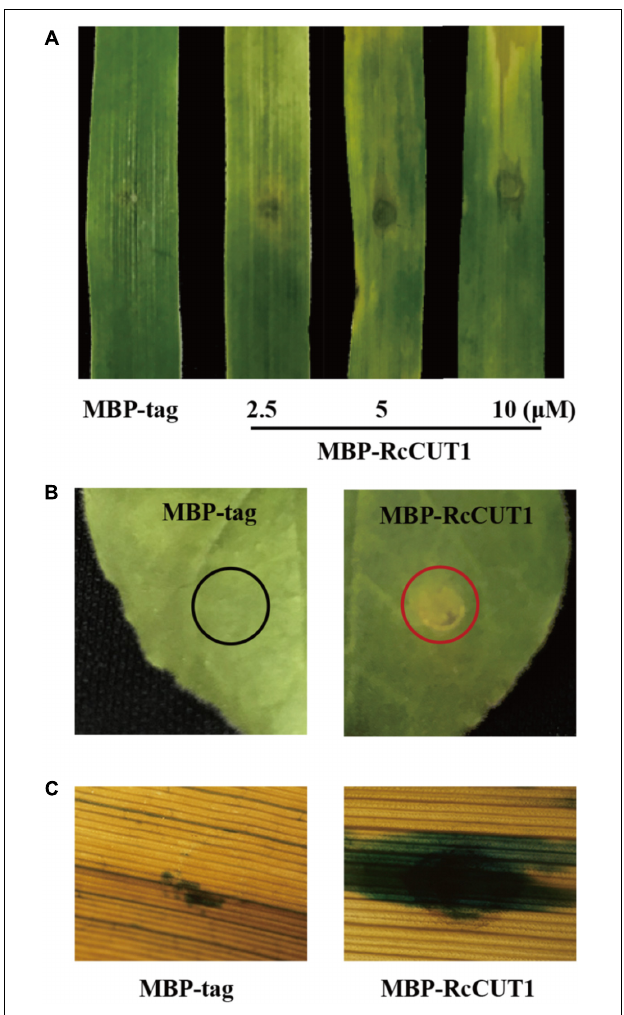
FIGURE 4 | The cell death induced by RcCUT1 in wheat and N. benthamiana leaves. (A) Wheat leaves 3 days post-inoculation with the MBP-RcCUT1 (2.5, 5, and 10 µ M) and the MBP-tag solution (5 µ M) as control. (B) N. benthamiana leaves with MBP-RcCUT1 treatment (5 µ M). The red and black circles indicate cell death and no cell death, respectively. (C) Wheat leaves with MBP-RcCUT1 treatment (5 µ M) stained by trypan blue. Dead wheat leaf cells were stained by trypan